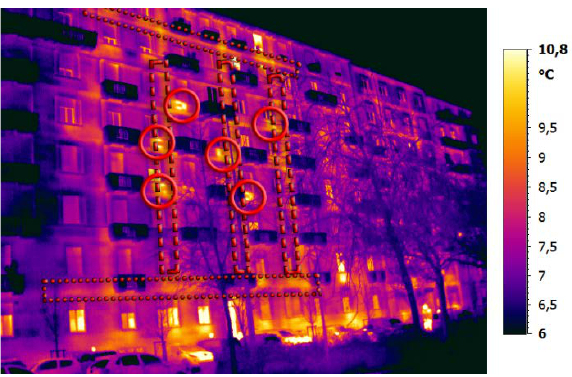
Figure 5 – Thermogram of the eastern façade of Case Study 2; outdoor air temperature 8 C, emissivity